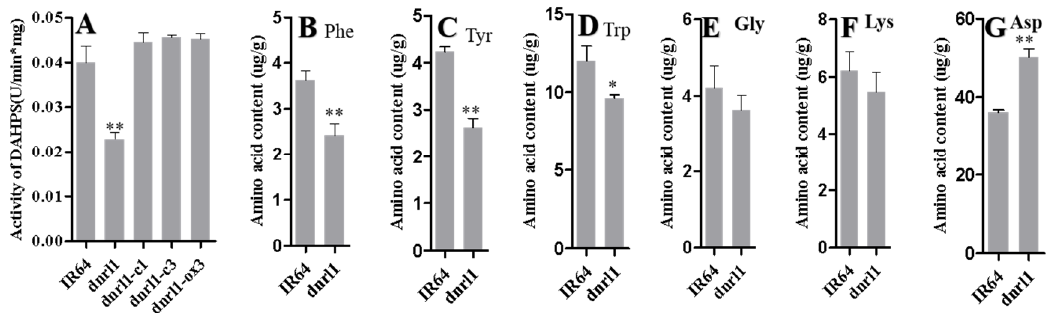
Figure 4. Comparison of 3-deoxy-7-phosphoheptulonate synthase (DAHPS) activity and amino acid